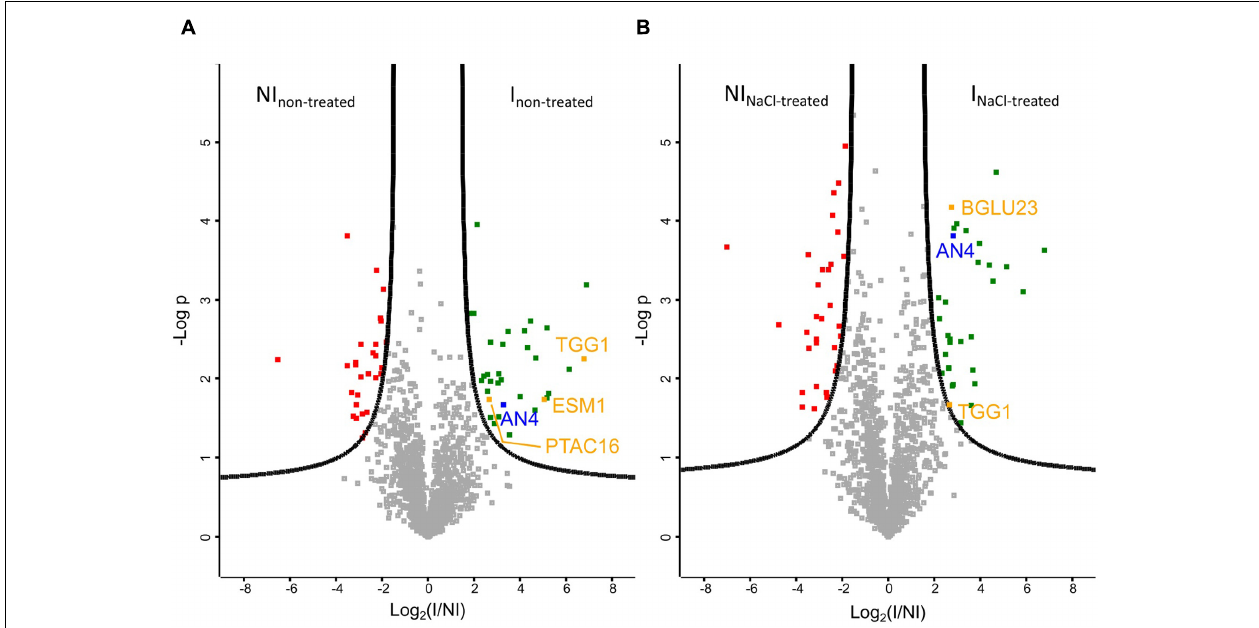
FIGURE 9 | Volcano plots of proteins identified by mass spectrometry ( N = 3). (A) Plant extract from non-treated Arabidopsis seedlings. FDR = 0.05. (B) Plant extract from Arabidopsis seedlings treated with 150 mM NaCl for 5 h. FDR = 0.01. AN4 is indicated in blue, possible interaction partners are shown in orange, Escherichia coli proteins which are significantly more present in the pull-down assays performed with the IPTG treated E. coli culture (I) in green and E. coli proteins which are significantly less present in these pull-down assays are shown in red. NI, non-induced.